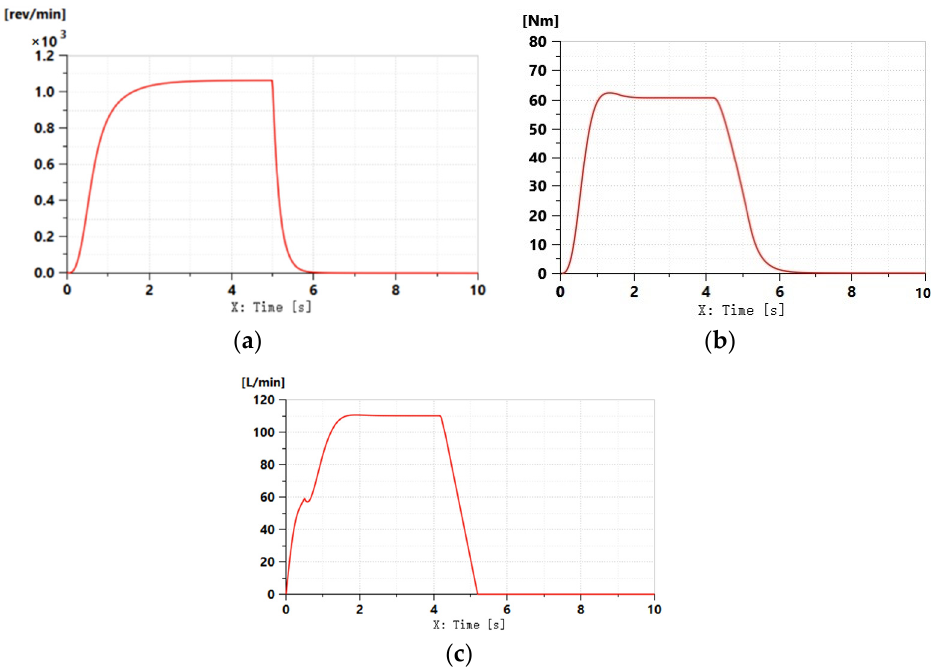
Figure 6. Braking simulation analysis: ( a ) hydraulic motor speed, ( b ) hydraulic motor torque, and ( c ) variable displacement pump outlet flow.